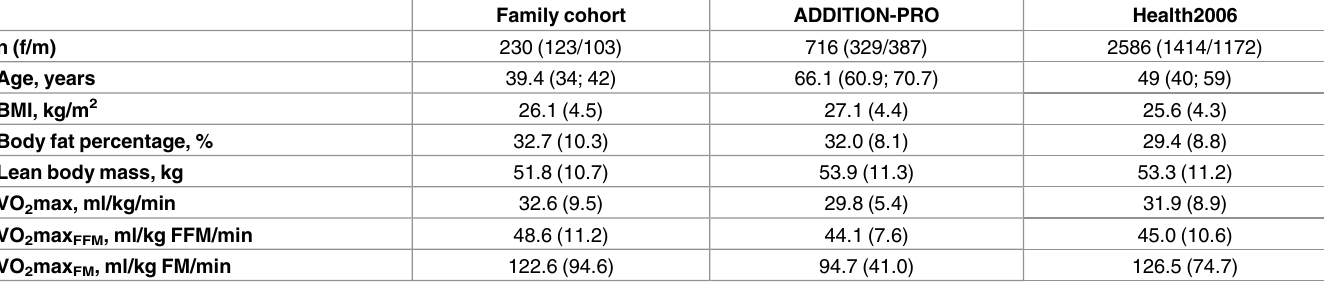
Table 1. Clinical characteristics of three Danish study populations included into the analysis.